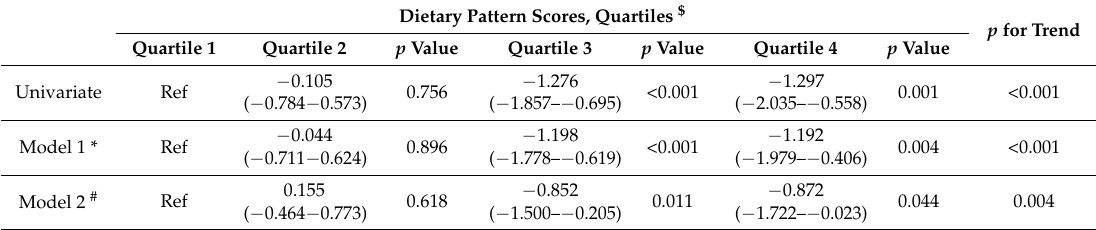
Table 5. Linear regression of the relationship between quartile of dietary pattern score levels and total